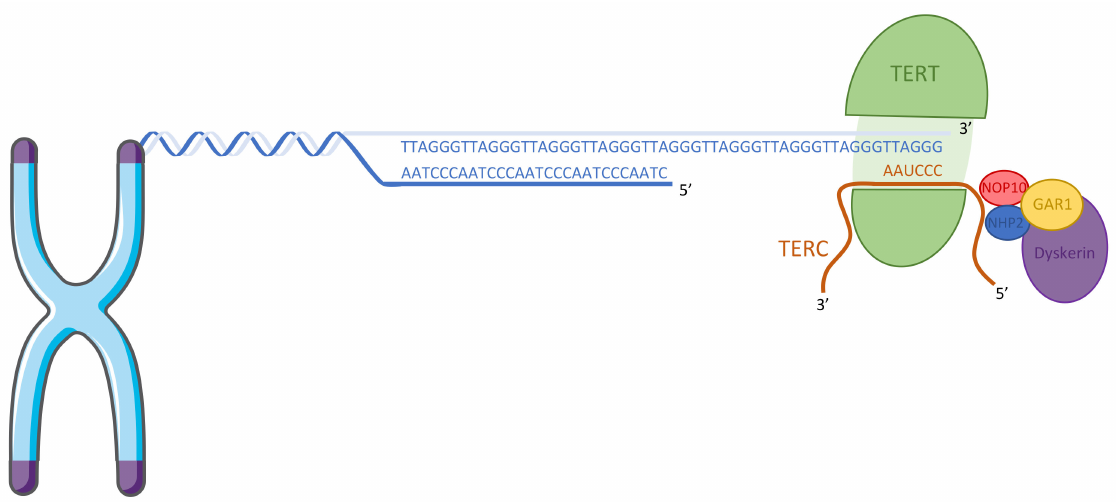
Figure 1. Structure of telomerase. The catalytic reverse transcriptase subunit TERT associate with the template RNA component TERC and is stabilized by the dyskerin complex (NOP10, NHP2, GAR1, and